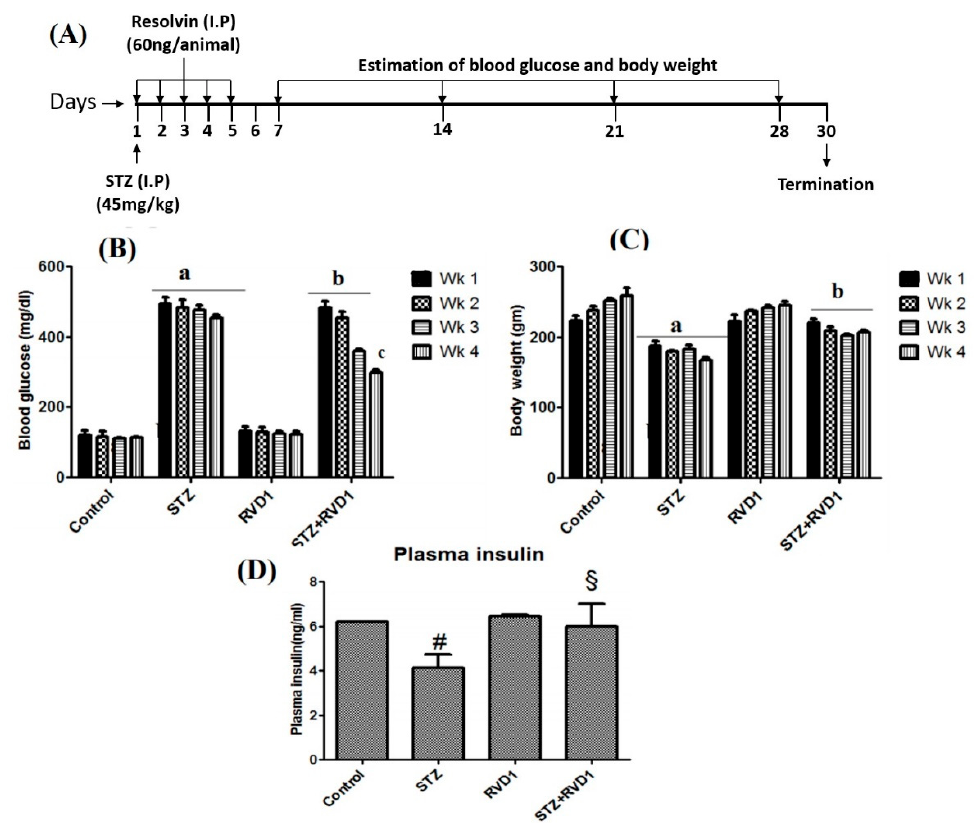
Figure 1. ( A ) Streptozotocin (STZ)-induced type 1 diabetes protocol. Type 1 diabetes mellitus was induced in